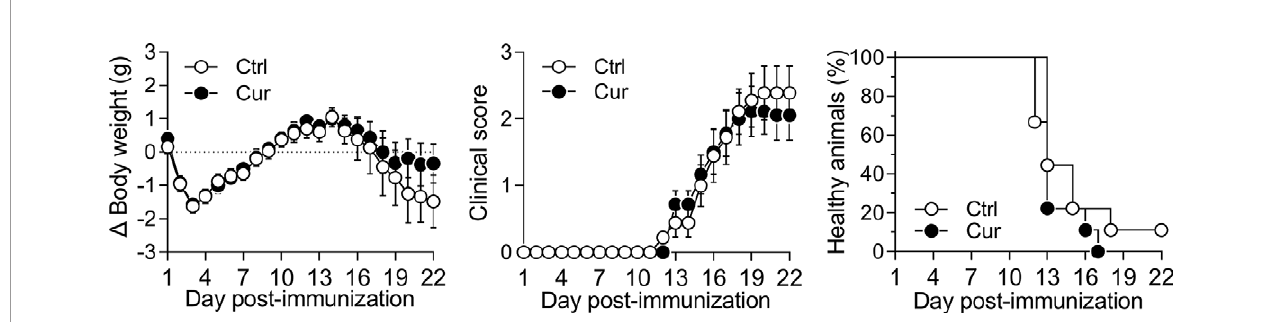
FIGURE 5 | Neuroprotective effect of curcumin is IL-10 dependent. IL-10 -/- mice were treated with vehicle (Ctrl) or curcumin (Cur) as shown in Figure 4A with minor modi fi cations (see Materials and Methods for detailed explanation). After immunization, animals were monitored daily and changes in body weight (left), clinical score (center) and percentage of healthy animals (right) were recorded. Data is presented as the mean ± SEM and a two-way ANOVA for repeated measures with Bonferroni ’ s post-test was performed (left and center). Percentage of healthy animals was plotted as a Kaplan-Meier curve and a Mantel-Cox test was performed (right). n=9 animals per group. No statistically signi fi cant differences were found between Ctrl and Cur groups.